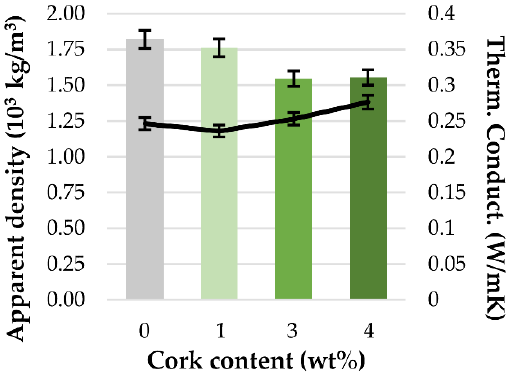
Figure 6. Correlation between apparent density (bar chart) and thermal conductivity (black line) of mortars containing increasing cork content. The error bars stand for standard deviation error.